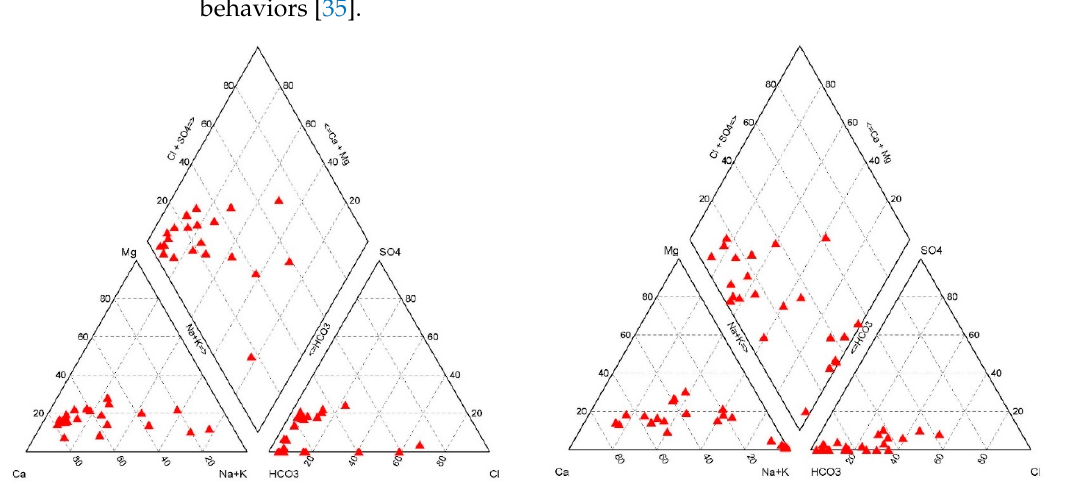
Figure 18. Trilinear Piper diagrams for the groundwater samples from the unconfined ( left ) and confined ( right ) aquifer of the study area (May 2019).